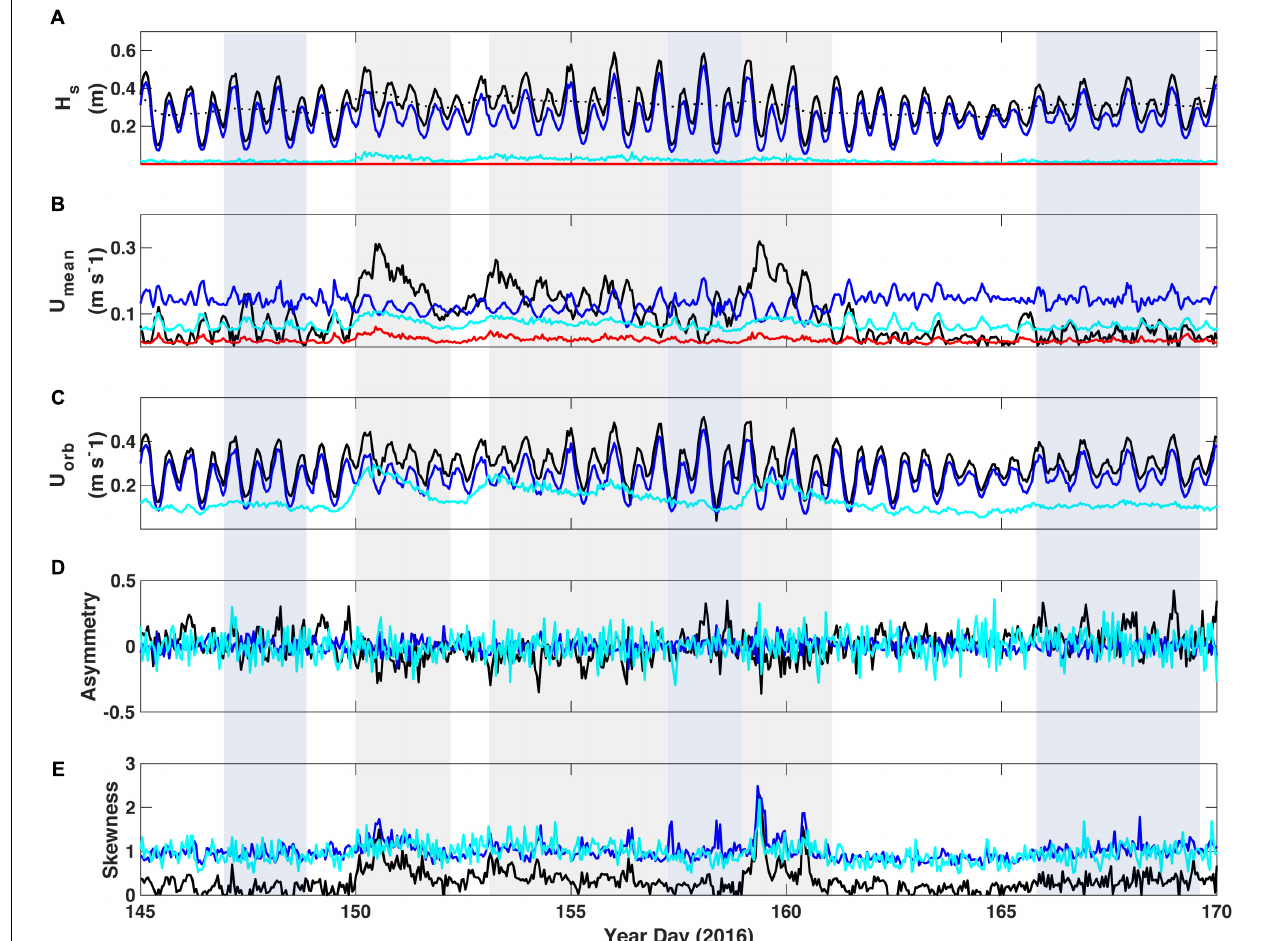
FIGURE 4 | Wave and current parameters delineated by spectral bandwidth at TR2 on the mid-reef flat. (A) Significant wave height; the black dotted line denotes the 40-h low-pass filtered wave height. (B) Burst mean near-bed current speed and (C) Near-bed wave-orbital velocity from 10 cm above bottom. (D) Wave asymmetry. (E) Wave skewness. Black = unfiltered data, blue = sea-swell band, cyan = infragravity band, and red = very-low frequency band. Parameters were calculated from hour-long bursts of continuous data; mean current speed of unfiltered data was derived from the vector sum of the burst mean U and V. Energy in the VLF band was significantly lower, if not zero, and is therefore not plotted in U orb , asymmetry or